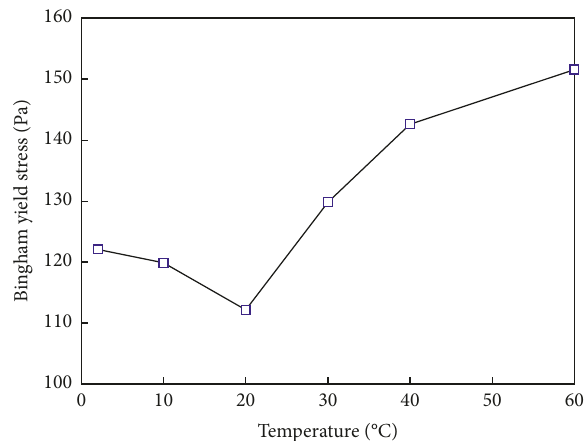
Figure 8: Effect of temperature on paste Bingham yield stress.